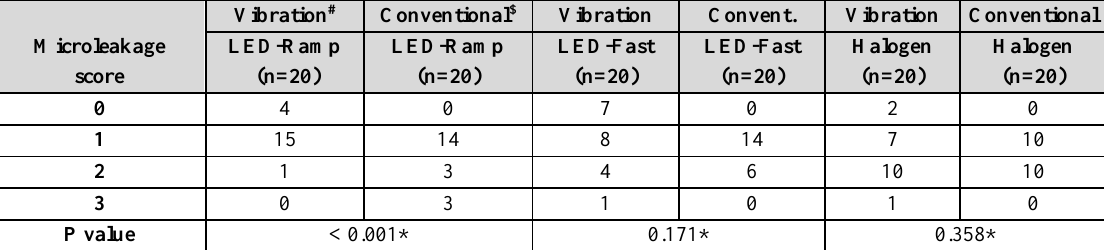
Table 2: Microleakage scores of each curing mode by the two condensation methods.